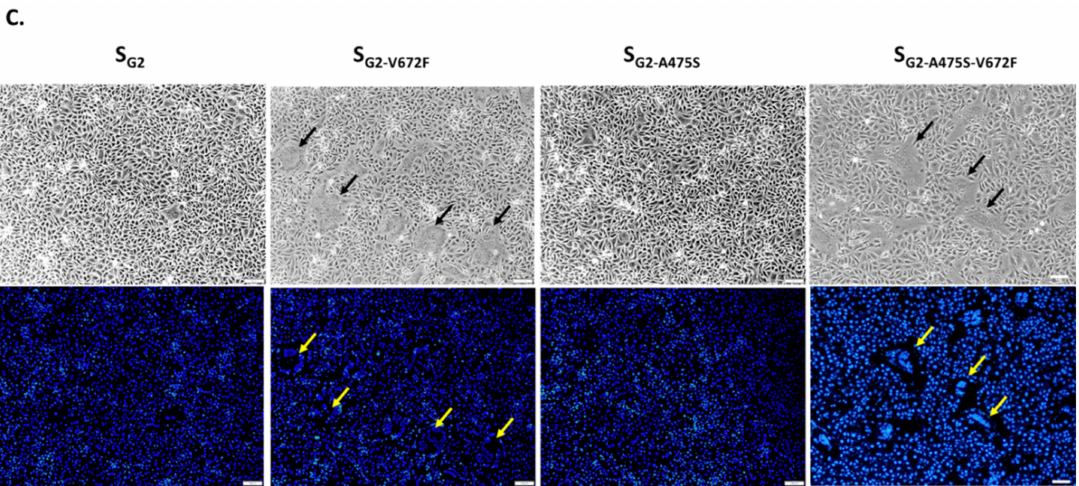
Figure 5. Effect of amino acid substitution in the RBD of S G2 on syncytium formation in VeroE6-APN cells. ( A ) VeroE6-APN cells were transfected with pCAGGS expressing S G2A with single amino acid substitution at positions 475, 493, 550, and 672 and treated with trypsin. At 24 hpt, cells were assessed for syncytium formation. Scale 50 µ m. ( B ) VeroE6-APN cells were transfected with pCAGGS expressing S G2A , S G2A-V672F , and S G2A-A475S-V672F and cultured in the presence of trypsin. At 24 hpt, cells were evaluated for syncytium formation. Hoechst was used to stain nuclei. Arrows denote the formation of the syncytium. Scale 100 µ m. ( C ) VeroE6-APN cells were transfected with pCAGGS expressing wild-type S G2 , S G2-V672F , S G2-A475S , and S G2-A475S-V672F and cultured in the presence of trypsin. At 24 hpt, cells were evaluated for syncytium formation. Hoechst was used to stain nuclei. Arrows denote the formation of the syncytium. Scale 100 µ